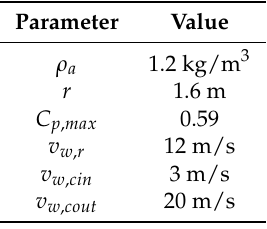
Table 2. Parameters of each wind turbine (4.5kW p